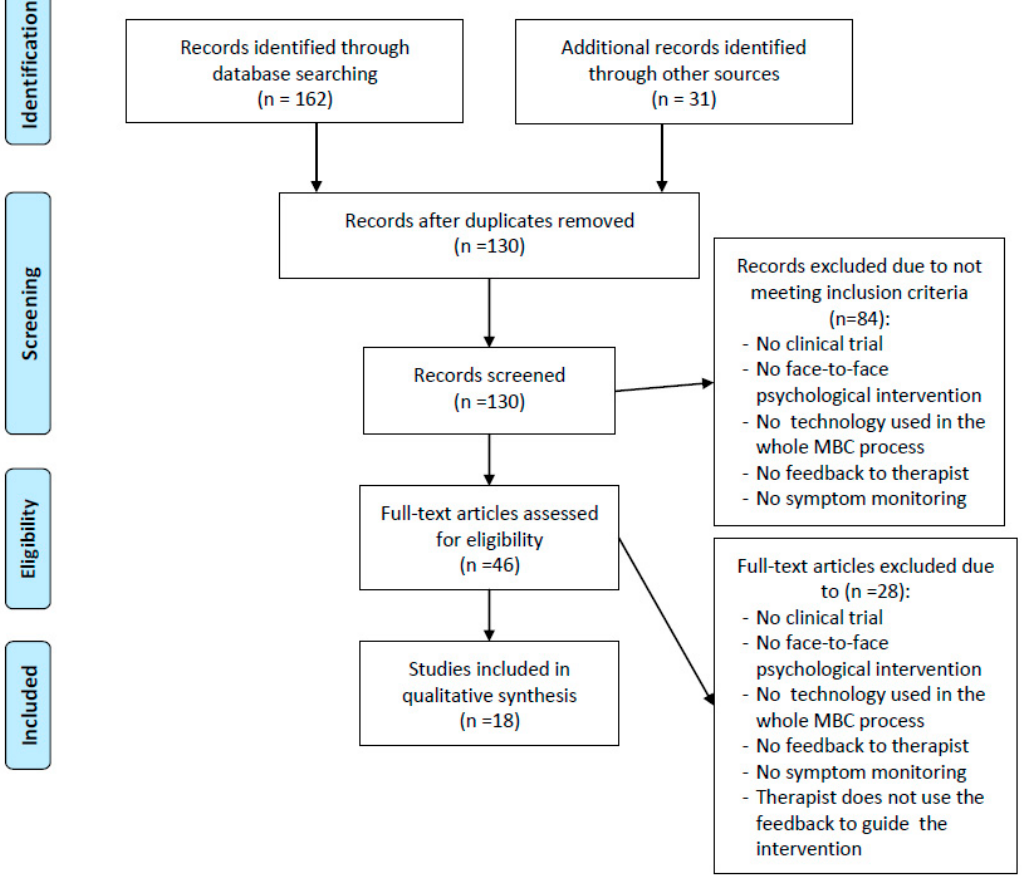
Figure 1. Flow diagram of study selection following PRISMA guidelines [26].